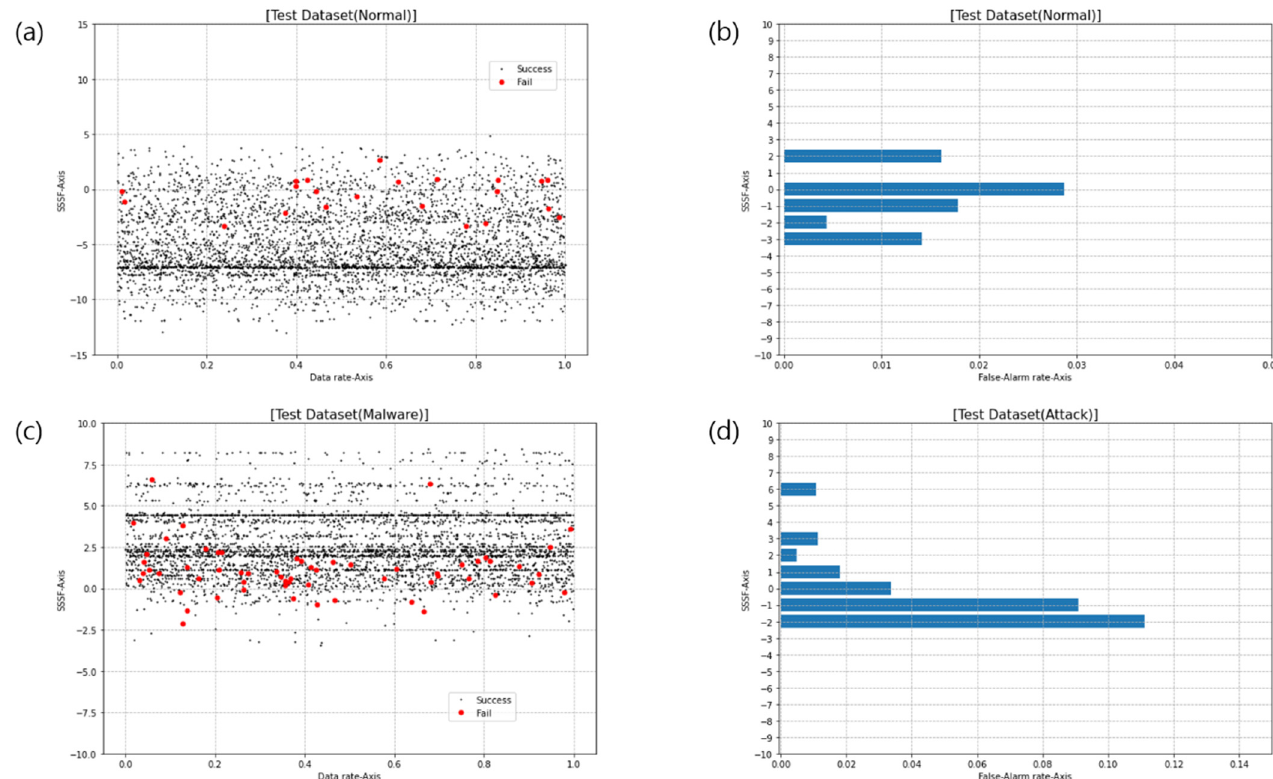
Figure 9. Prediction success/failure distribution in SSSF of malware dataset: ( a ) success/failure distribution of the data predicted as normal in the test dataset; ( b ) group of SSSF success/failure distribution of the data predicted as normal in the test dataset; ( c ) success/failure distribution of the data predicted as an attack in the test dataset; ( d ) group of SSSF success/failure distribution of the data predicted as an attack in the test dataset.